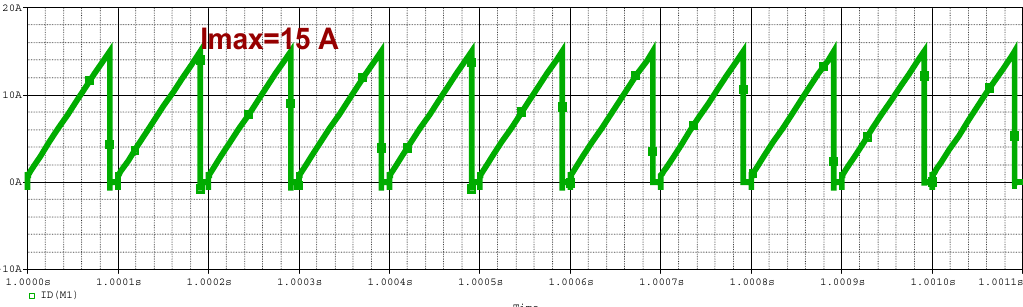
Energies 2019 , 12 , x FOR PEER REVIEW Figure 33. Voltage across switch “s” of the bidirectional CUK converter for a 400-V output [33].